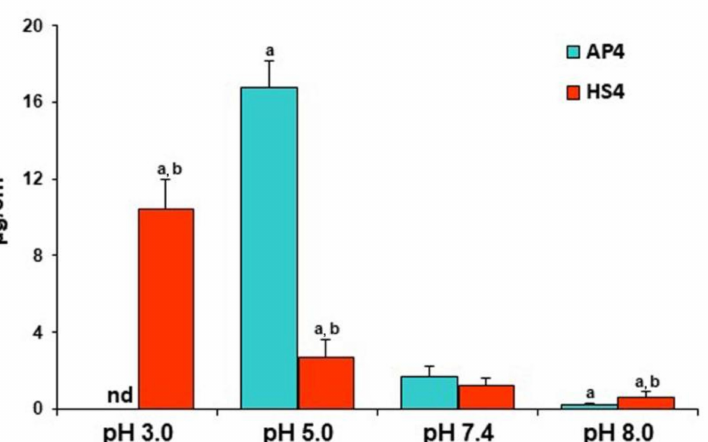
Figure 10. The BSA adsorption expressed per unit surface area by pectin gel beads incubating in PBS at different pH for 24 h. The data are presented as the mean ± S.D. ( n = 5). a p < 0.05 vs. PBS pH 7.4; b p < 0.05 vs. the corresponding AP4 gel